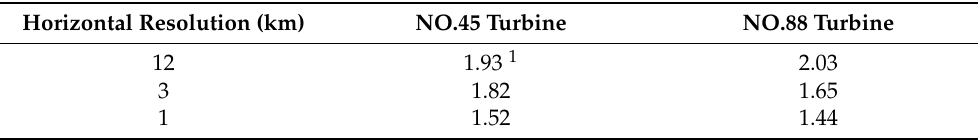
Table 2. The RMSE of wind speeds for selected turbines with different horizontal resolutions. Horizontal Resolution (km) NO.45